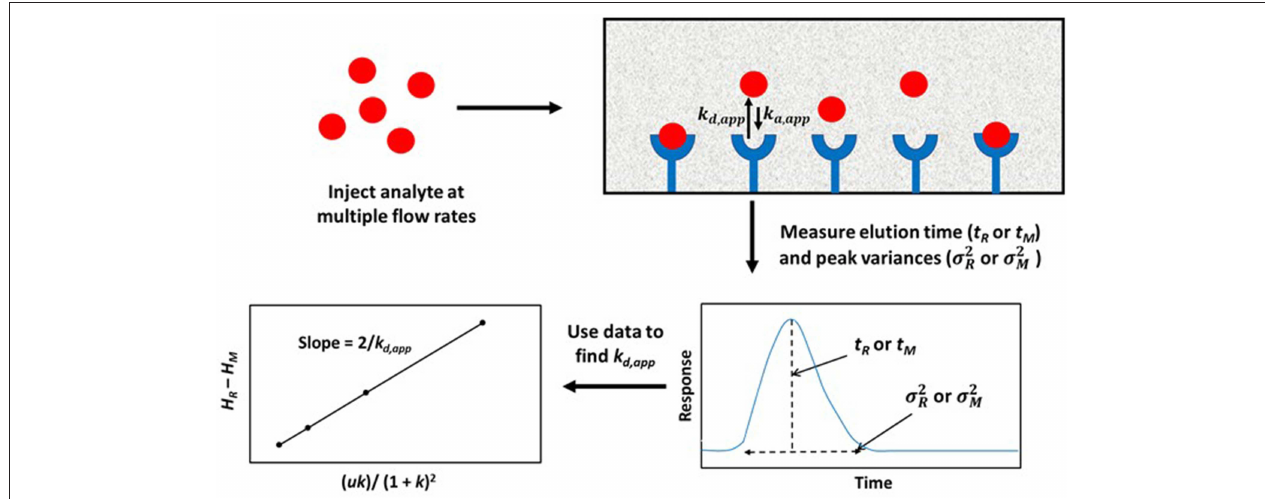
FIGURE 4 | General scheme used for studying analyte interactions with a binding agent by using peak profiling. Terms: t R , retention time of the analyte on an affinity column; t M , elution time of a non-retained solute or analyte on a control column; σ 2 R , peak variance of analyte on the affinity column; σ 2 M , peak variance of the non-retained solute or analyte on a control column; H R , total plate height obtained for analyte on the affinity column; H M , total plate height obtained for non-retained solute or analyte on a control column; u , linear velocity of mobile phase; k , retention factor of analyte on the affinity column; k d , app , apparent dissociation rate constant; k a , app, apparent association rate constant.